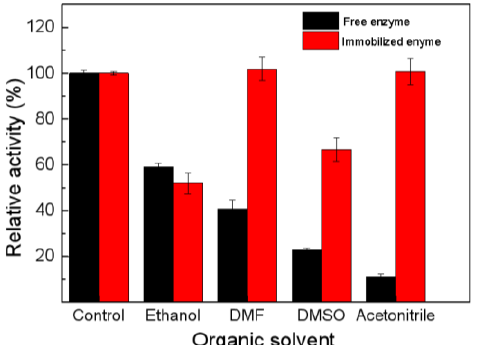
Figure 7. Effects of different organic solvents on free and immobilized laccase activity.